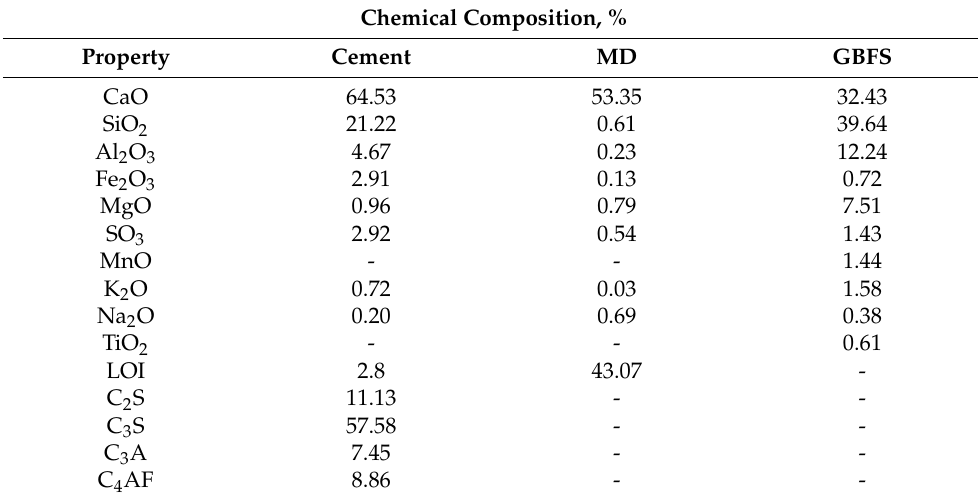
Table 2. Chemical analyses of the raw